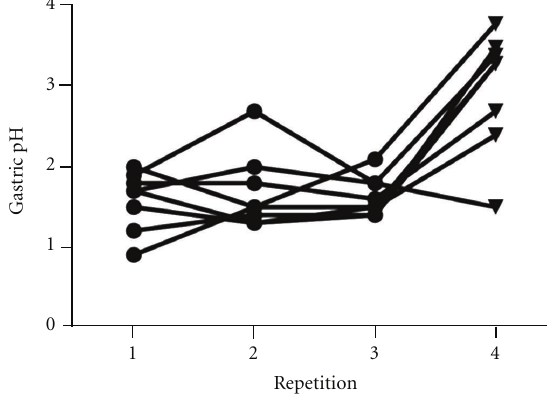
Figure 4: Gastric pH before and during treatment with ranitidine. The first 3 repetitions (circles) are before treatment with ranitidine, the 4th repetition (triangles) is during treatment with ranitidine, and gastric pH was lower for all 3 repetitions before treatment with ranitidine than the repetition during treatment with ranitidine ( P < 0 .